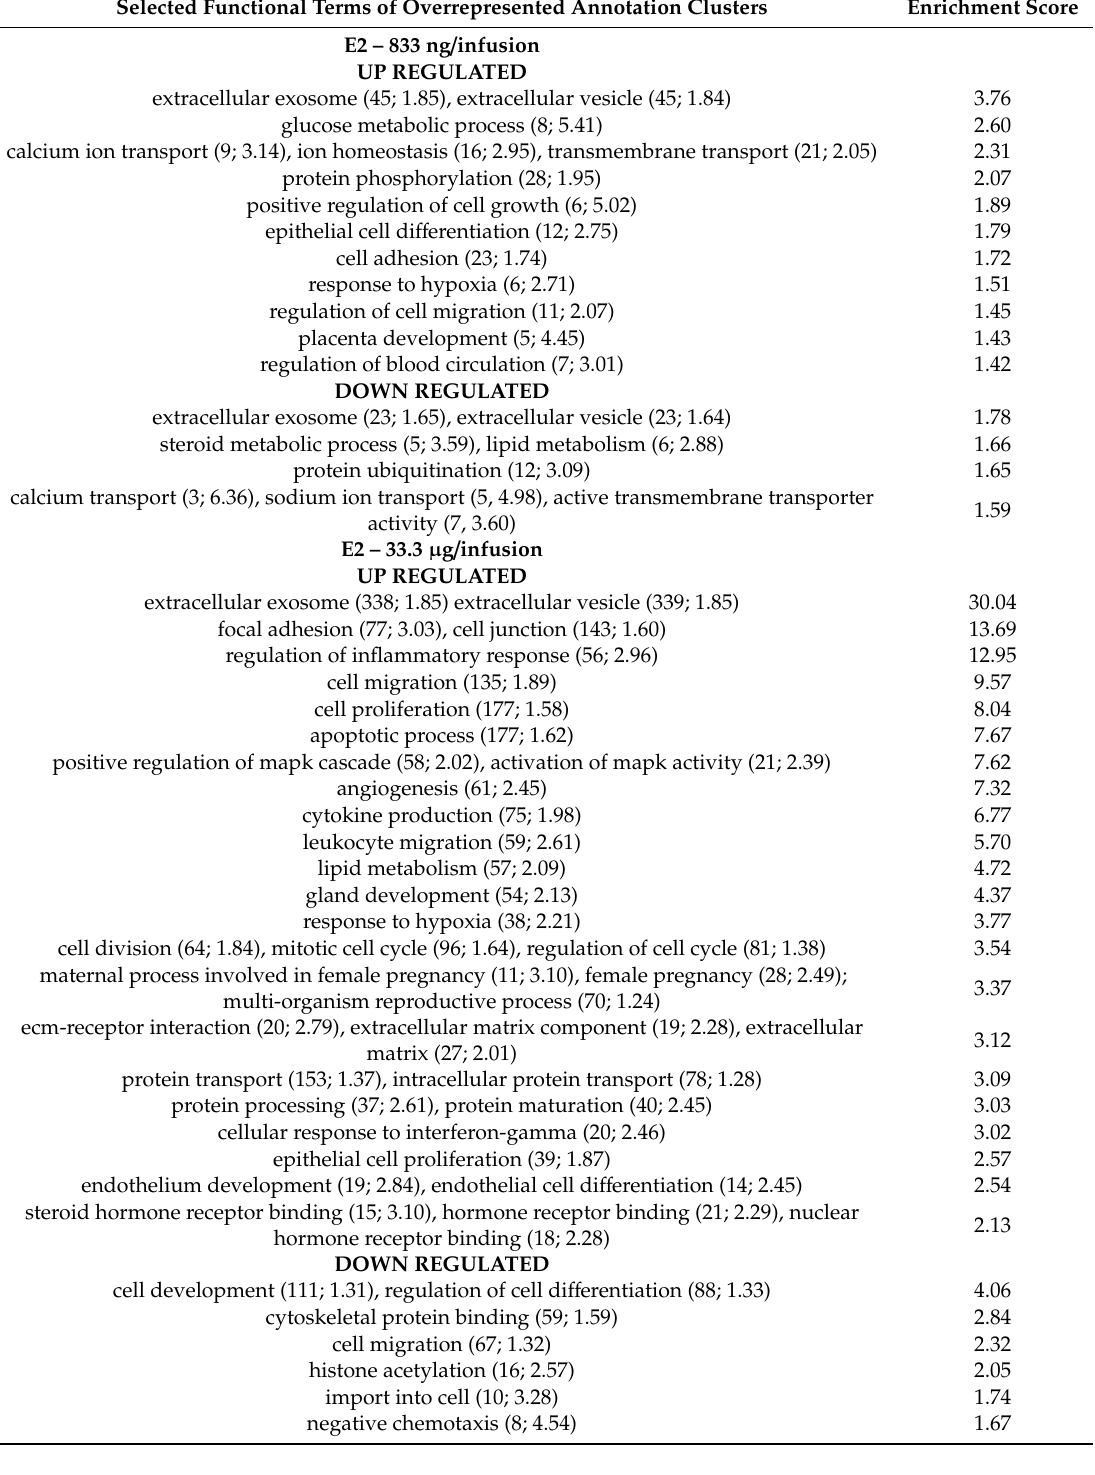
Table 1. Selected results Database for Annotation, Visualization, and Integrated Discovery (DAVID) functional annotation clustering for di ff erentially expressed genes in porcine